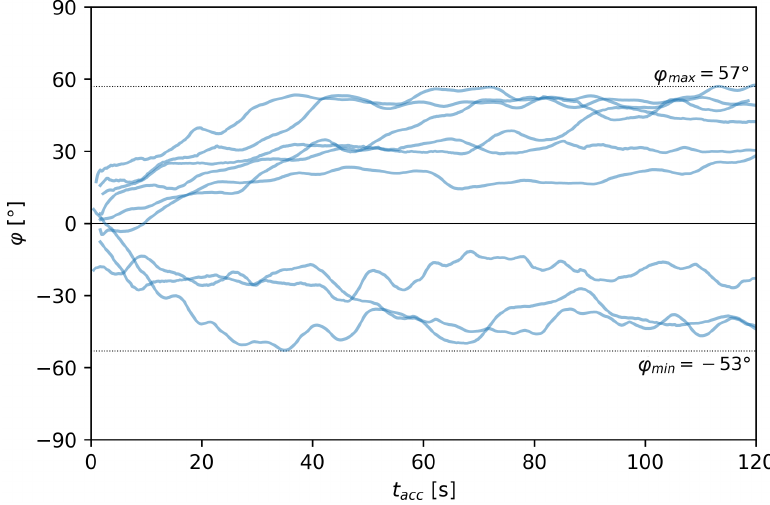
Figure 11. Log rotation of selected n = 9 AC 1 logs during their rotation phase at the pier. Log-induced changes in the flow field. A log accumulation at a bridge pier reduces the open flow cross section and will affect the flow conditions in the vicinity of the bridge pier. The surface flow field is illustrated in Figure 12 for two logs (log #7 and #22). The